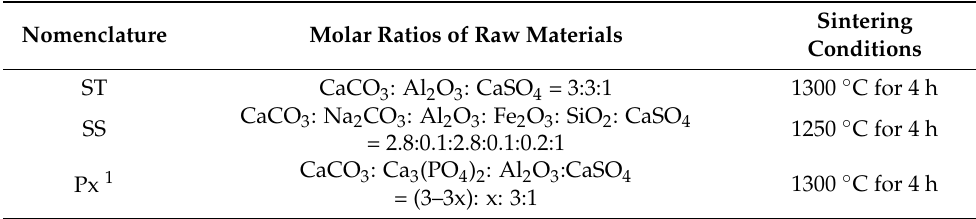
Table 1. Molar ratios of raw materials and sintering conditions for different types of ye’elimite.